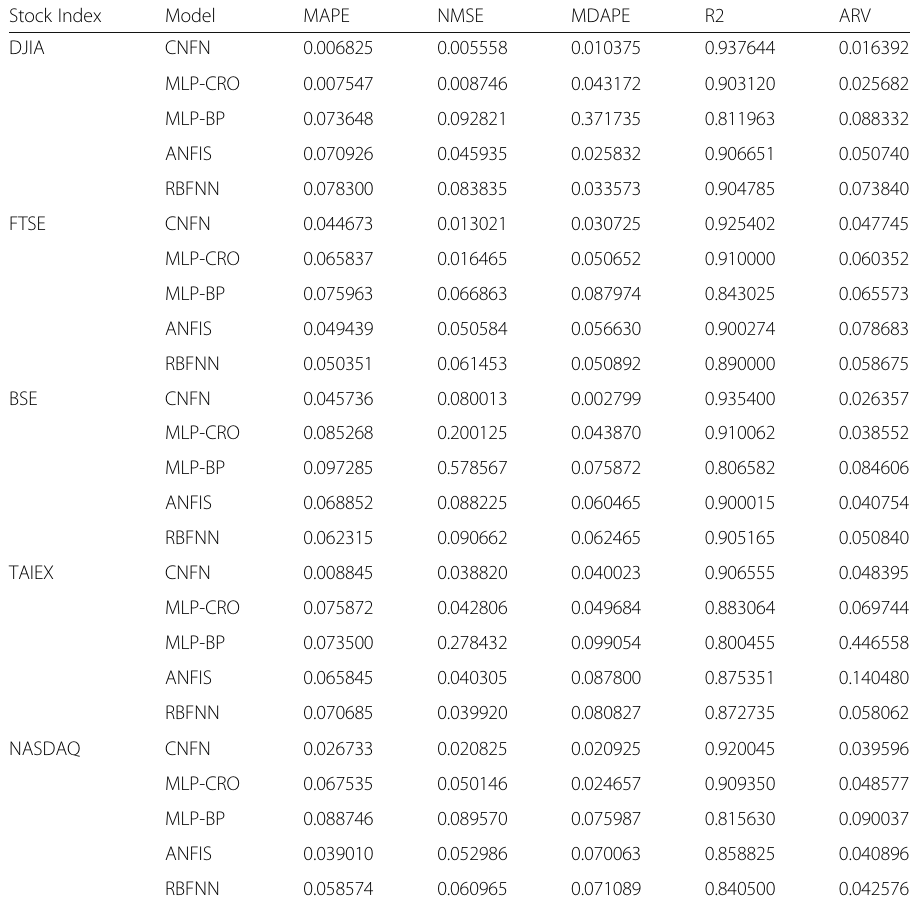
Table 8 One-month-ahead forecasting comparison Stock